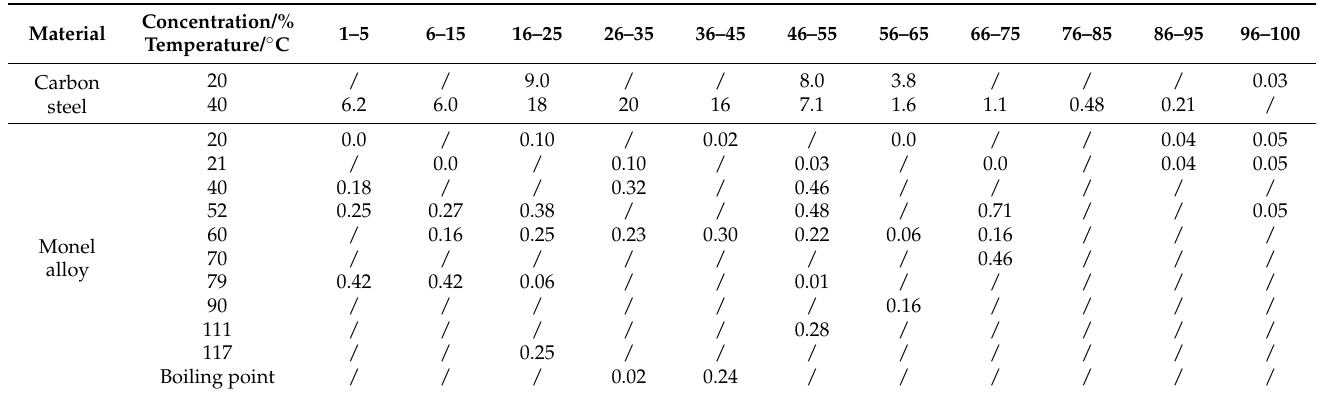
Table 4. Corrosion rates of carbon steel and Monel alloy at different temperatures and concentrations. Concentration/% Material Temperature/ ◦ C Carbon